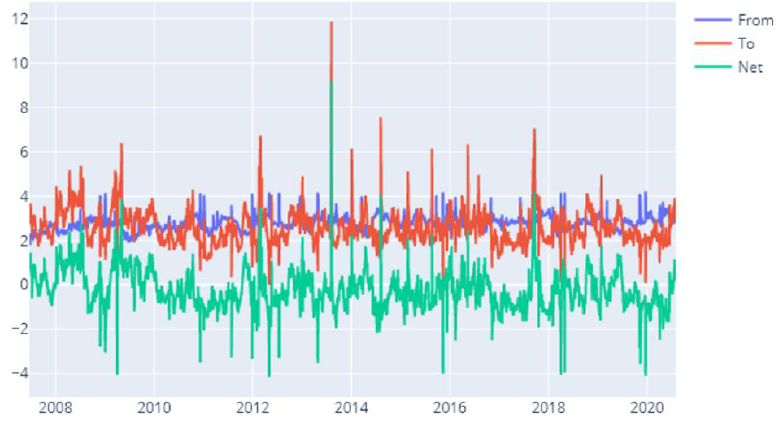
Figure 6. Entropy spillovers — MES.